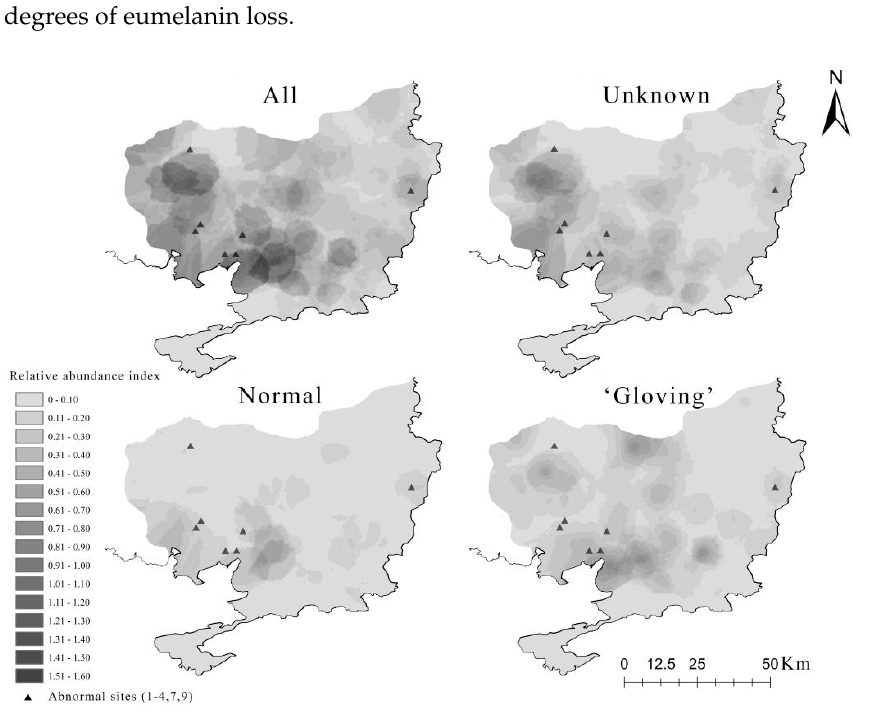
Figure 3. Relative abundance map of all yellow-throated martens (unknown, normal or ‘gloving’ not differentiated), and those with unknown, normal and ‘gloving’ during 2014–2015 in the research area in Northeast Tiger and Leopard National Park, China. Camera observations of white spotted and dilute martens coincide with the ‘gloving’ population distribution; abnormal sites 5 and 8 are not in the area.